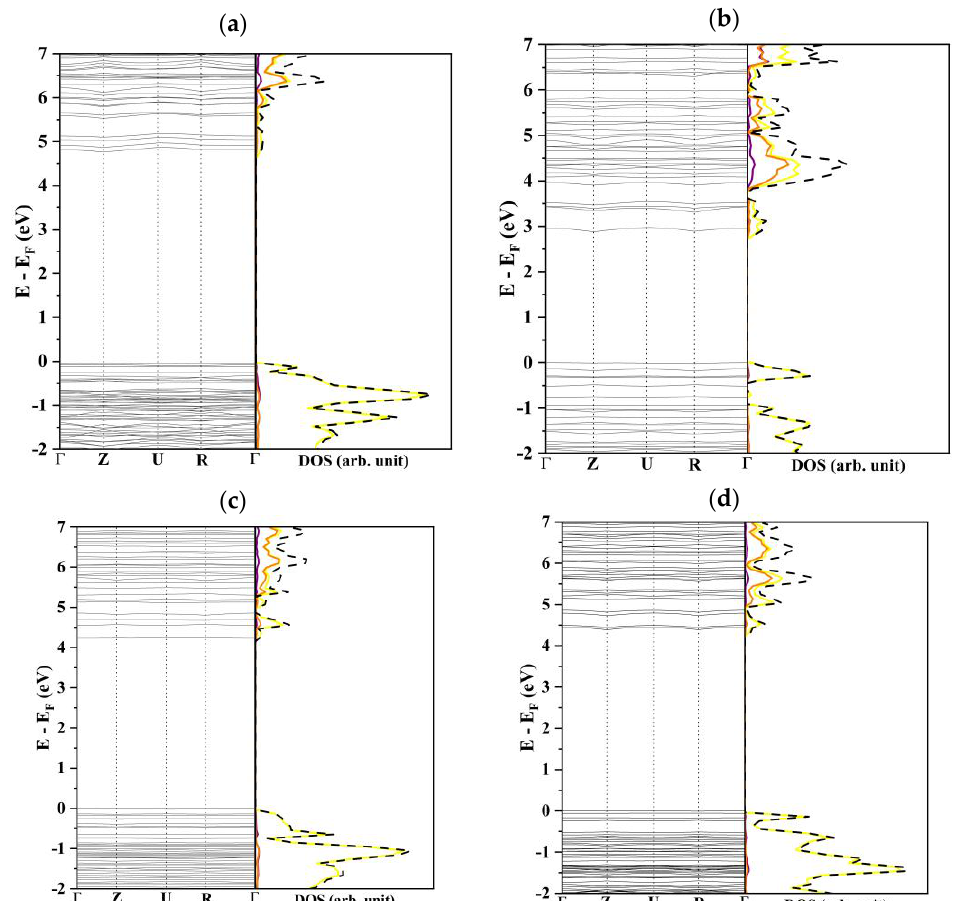
Figure 4. Band structure and density of states of ( a ) (100), ( b ) (010), ( c ) (011), and ( d ) (210). The curves in purple, orange, yellow, and black are related to the lithium, phosphor, sulfur, and total atoms contributions, respectively.